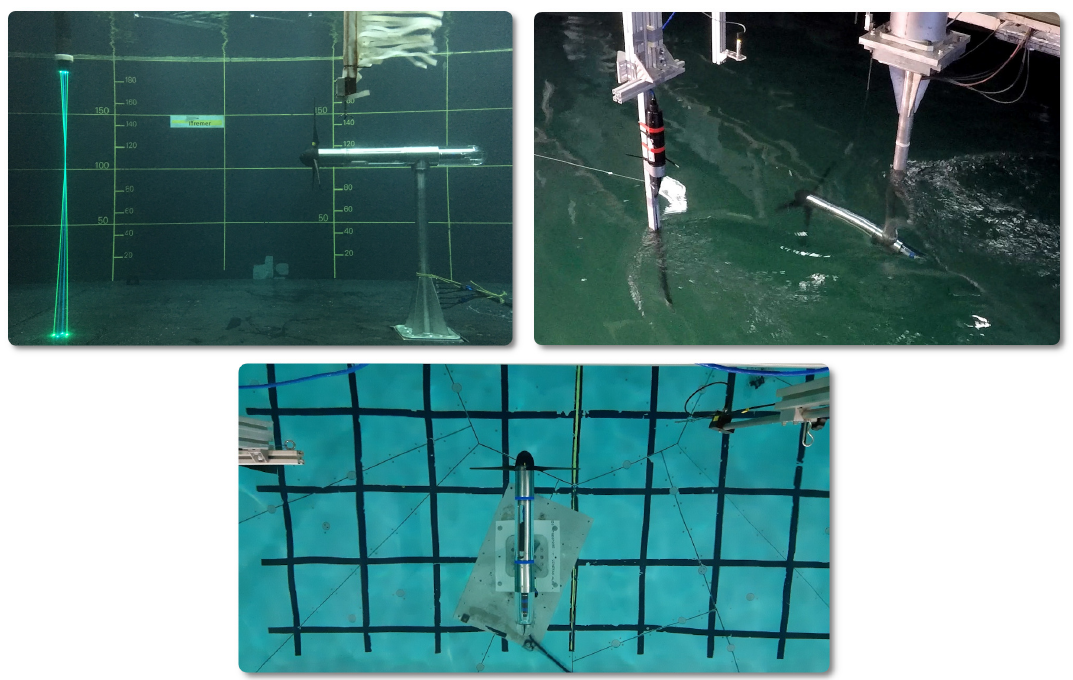
Figure 4. The 3-bladed instrumented turbine in the wave and current flume tank of I FREMER ( top left-hand side ), in the towing tank of C NR -I NM ( top right-hand side ) and in the F LO W AVE circular wave and current tank ( bottom ).